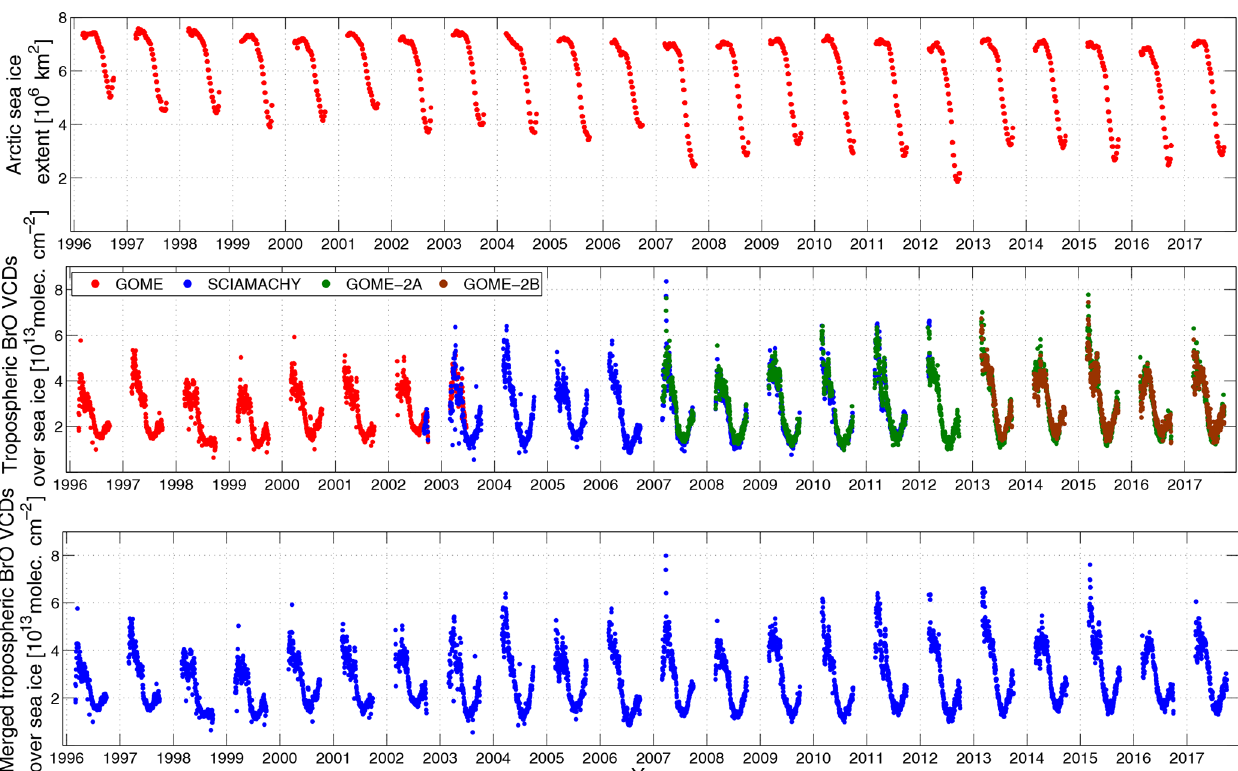
Figure 8. (a) Arctic sea ice extent from March until September from Tschudi et al. (2019); (b) tropospheric BrO VCDs above sea ice in the Arctic (GOME data are shown in red, SCIAMACHY in blue, GOME-2A in green and GOME-2B in brown); and (c) the sensor merged tropospheric BrO VCDs above sea ice in the